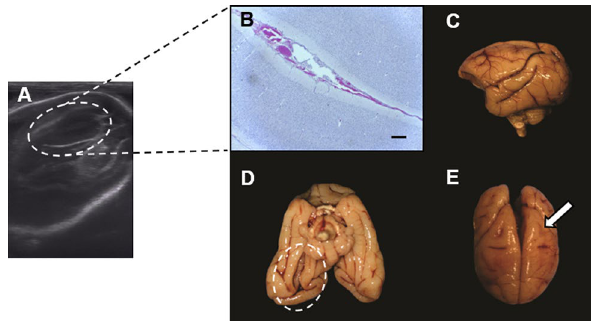
Figure 5. Experimental ZIKV infection in pregnant squirrel monkeys: fetal growth and neuropathology of the newborn vertical ZIKV infection (N-1C) after intradermal infection of its mother (1C) during the 1st GT. ( A ) Ultrasound image showing the area with right lateral ventriculomegaly (incomplete circle). ( B ) Histopathological image showing right ventricular edema and ventriculomegaly (100 × magnification scale bar, 25 µm). ( C ) Gross image of the right brain hemisphere showing marked vessel congestion. ( D ) Crude image of the brain showing distal rotation of the brain in the occipital region and right hemisphere (incomplete circle). ( E ) Gross brain image showing groove deformity in the left hemisphere parietal region (white